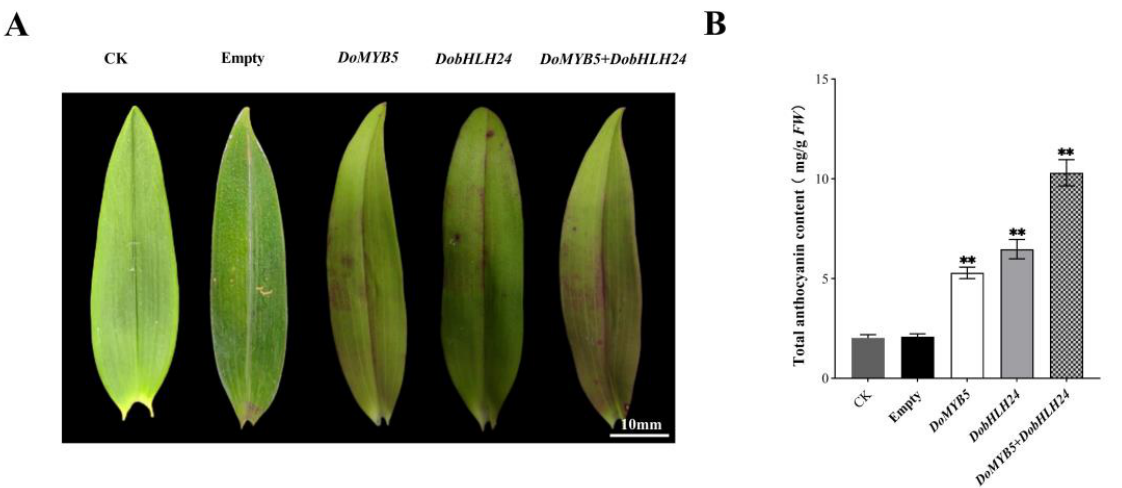
Figure 3. DoMYB5 and DobHLH24 regulated anthocyanin biosynthesis in D. officinale . ( A ) The phenotype of leaves transiently expressing empty vector, DoMYB5 , DobHLH24, and DoMYB5 + DobHLH24 and the uninjected plant (CK). ( B ) Anthocyanin content was determined 10 days after injection into the leaf of D. officinale . ** Extremely significant difference ( p < 0.01).